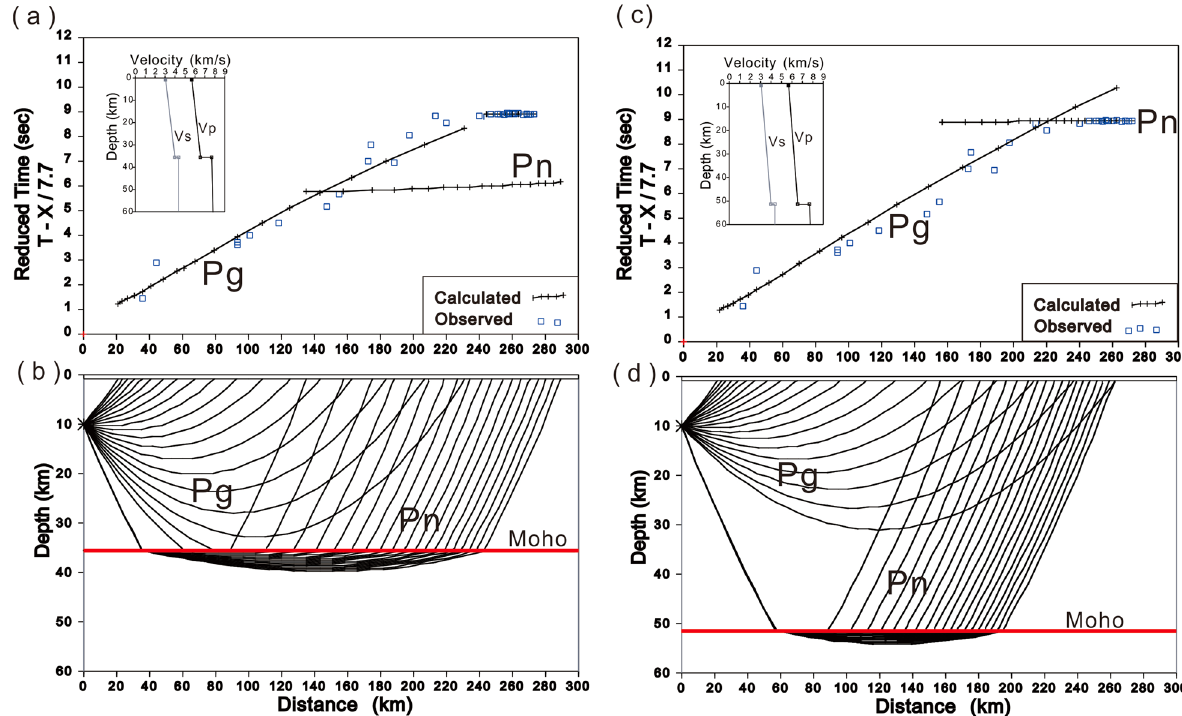
Fig. 10 Comparison of observed and calculated P waves for Event 3. Pg are the direct P‑waves and Pn are refracted from the Moho‑discontinuity. Calculated results of a , c the reduced travel‑times of b , d two groups of ray‑paths by given the Moho‑depth of 36 and 52 km,